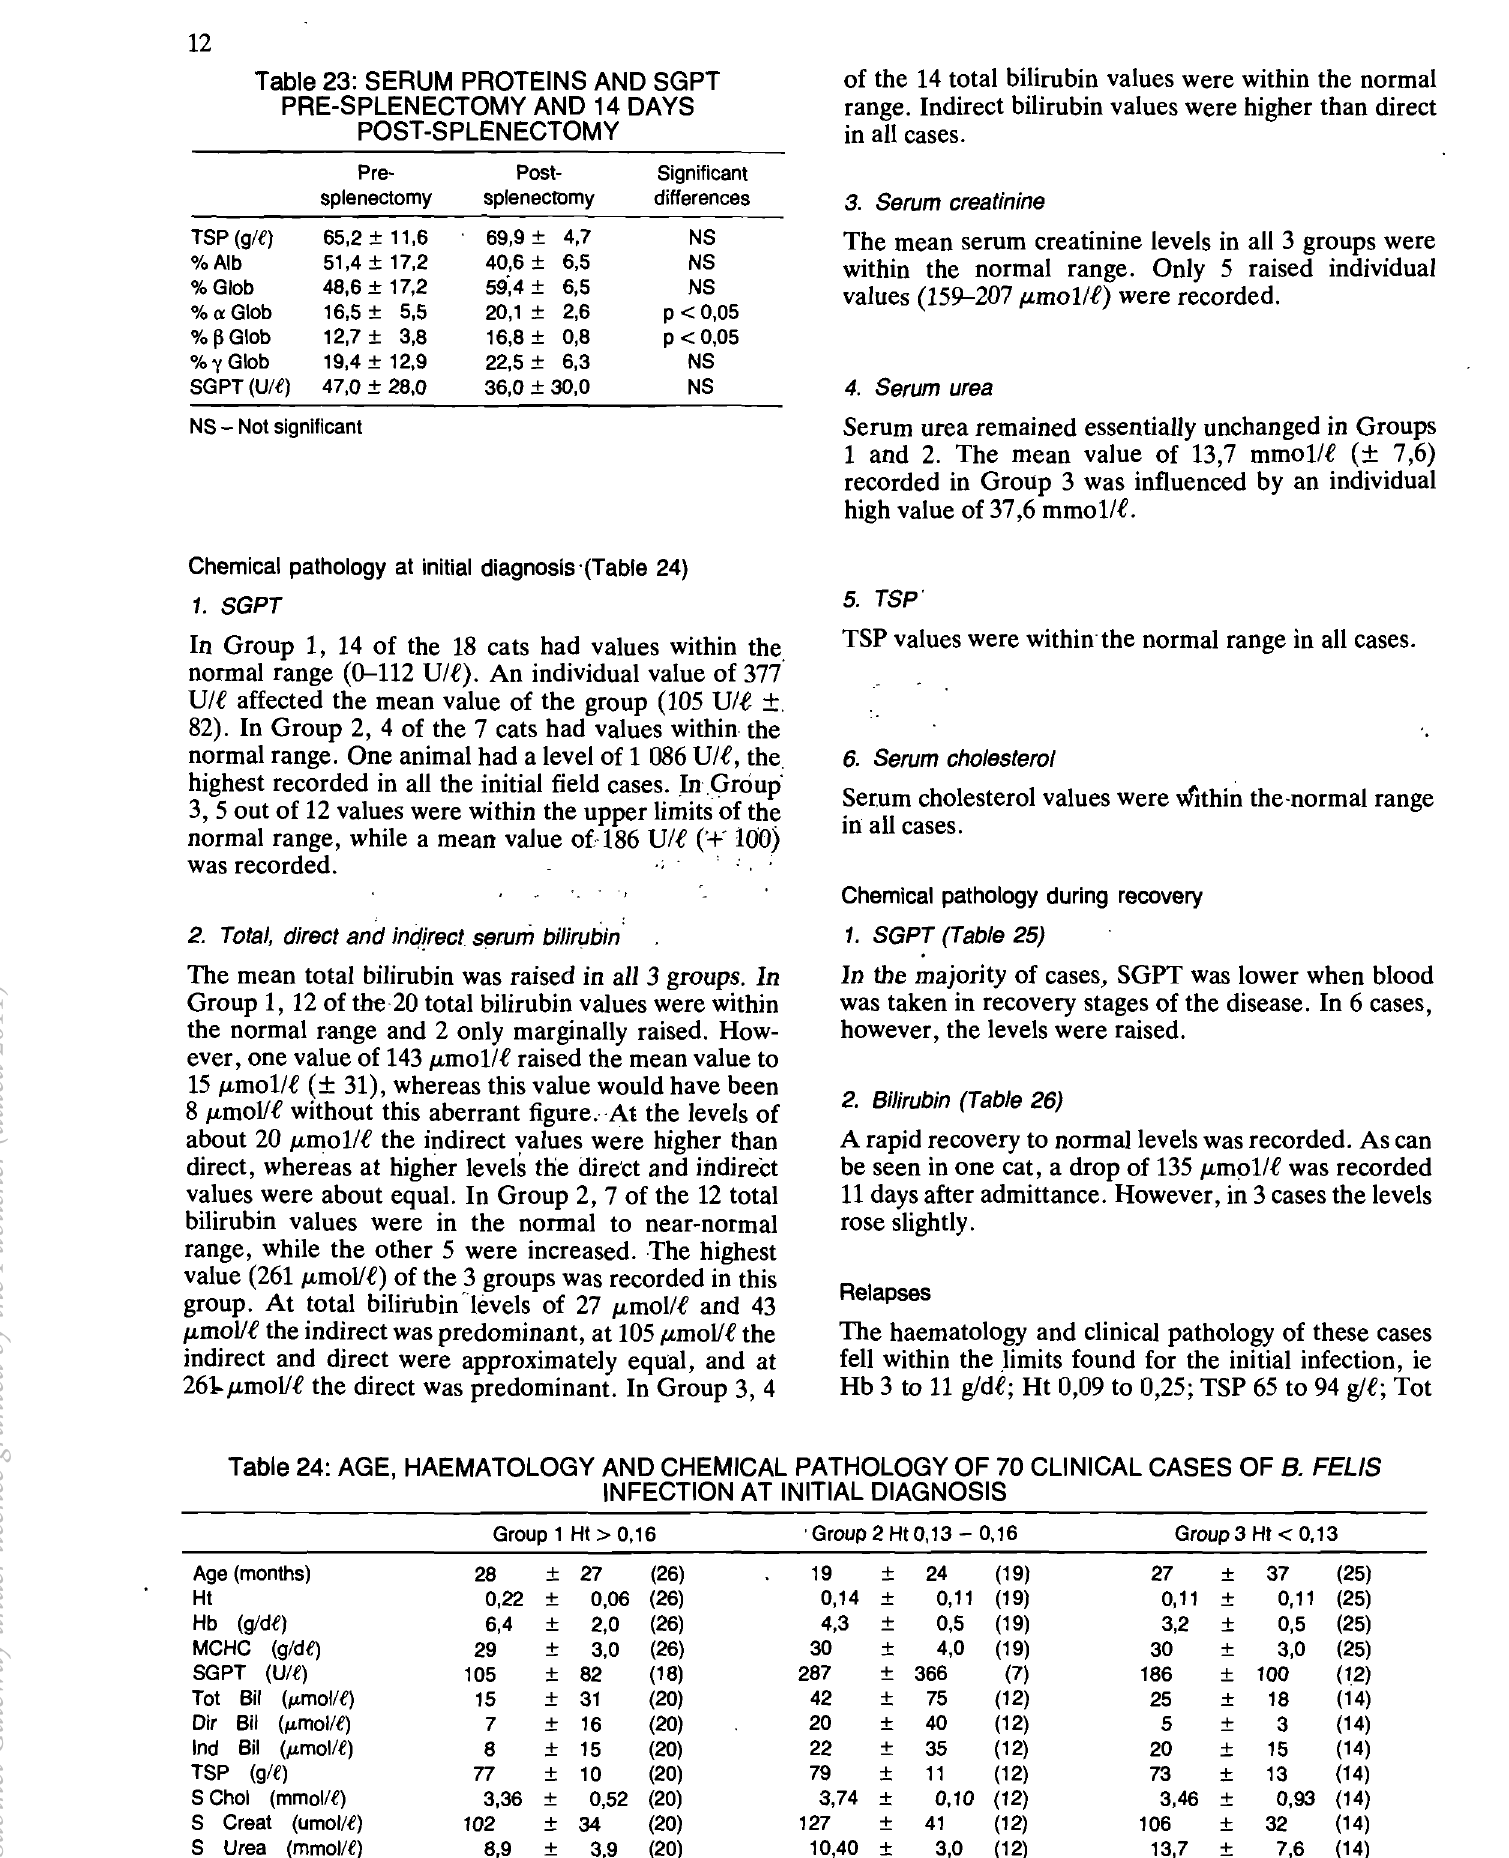
Table 23: SERUM PROTEINS AND SGPT